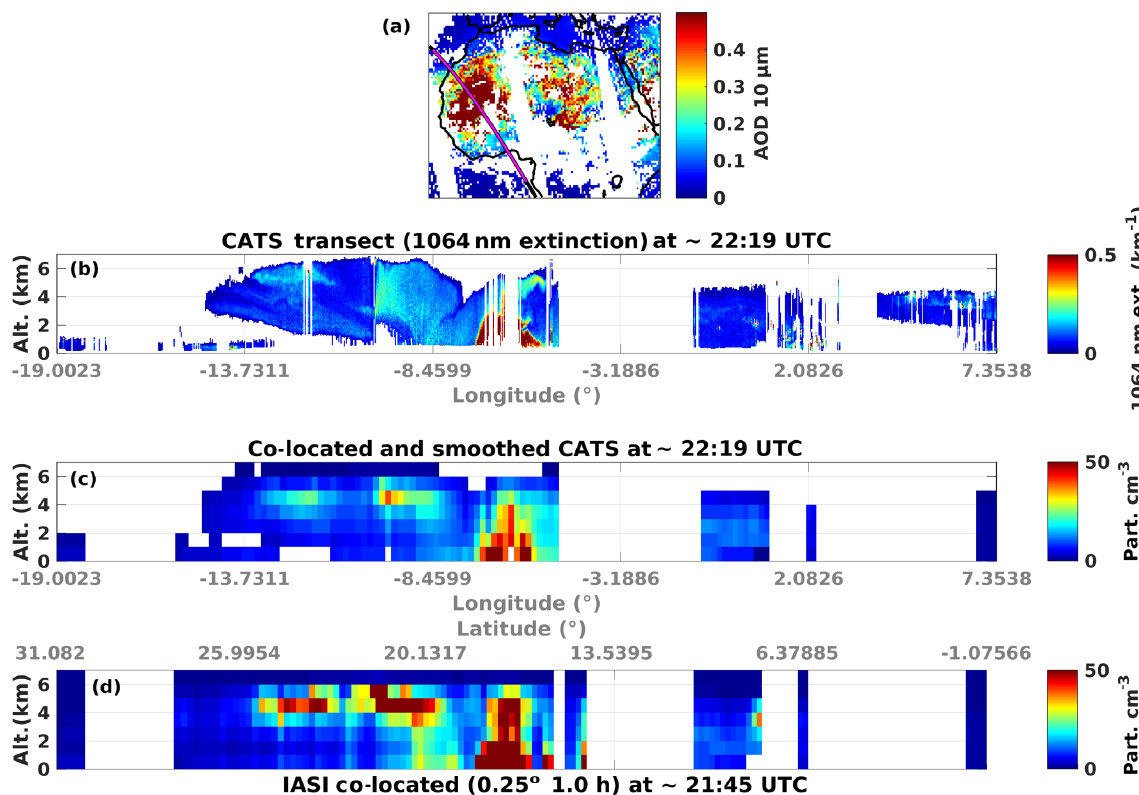
Figure 12. Same as Fig. 11 but with a co-located track on 19 June 2015. The pink track covers the western region of the